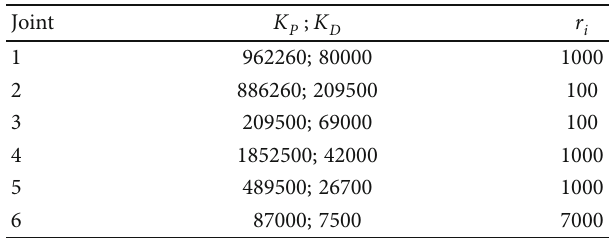
Figure 2: Control scheme of the robot. Table 1: Controller parameters of each